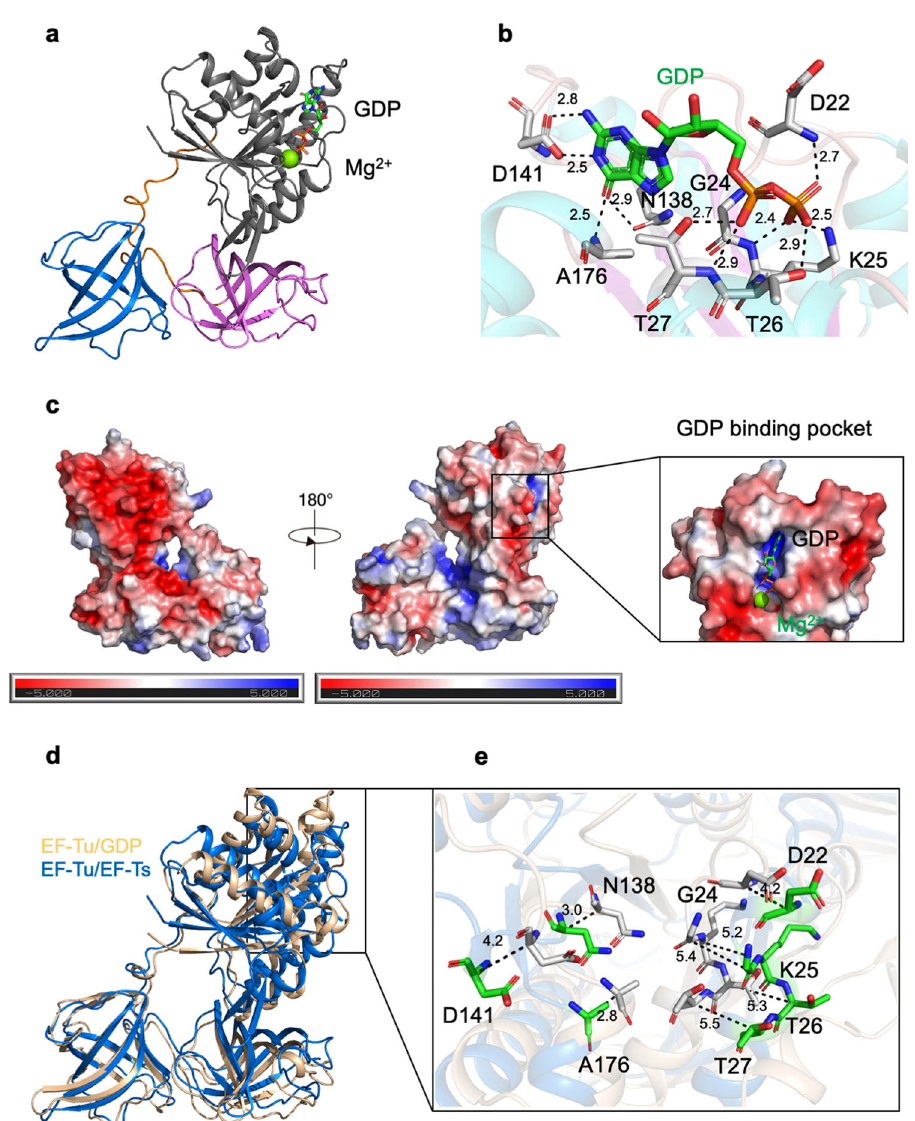
Fig. 4 Critical residues in the GDP-binding pocket. a A ribbon representation of the EF-Tu (cid:129) GDP structure, which is colored as Fig. 1a. GDP and Mg 2 + were located in Domain I. GDP is shown as sticks, and Mg 2 + is shown as a green sphere. b Representation of GDP-binding sites in the EF-Tu (cid:129) GDP complex. The broken black lines represented the hydrogen bonds formed between EF-Tu and GDP. The related residues were labeled and shown as sticks. c The electrostatic potential surface of the EF-Tu (cid:129) GDP complex. Red indicated the negative potential, and blue indicated the positive potential. GDP is shown as sticks, and Mg 2 + is shown as a green sphere. d Superimposition of Mtb EF-Tu between the EF-Tu (cid:129) GDP (yellow) and EF-Tu (cid:129) EF-Ts (marine) complexes. The RMSD value for the C α alignment between the two structures was 0.711 Å. e The detailed shift of GDP-bound residues between the EF-Tu (cid:129) GDP and EF- Tu (cid:129) EF-Ts complexes. The broken black lines represented the shifting of labeled signi fi cantly affects the nucleotide binding of unphosphorylated Mtb EF-Tu, but not the phosphorylated protein 44 . Pulvomycin can inhibit polypeptide synthesis in B. brevi s and E. coli 45 . In addition, enacyloxin Iia is active against different Gram-positive and Gram-negative bacteria except for Mtb and M. Smegmatis 46 .